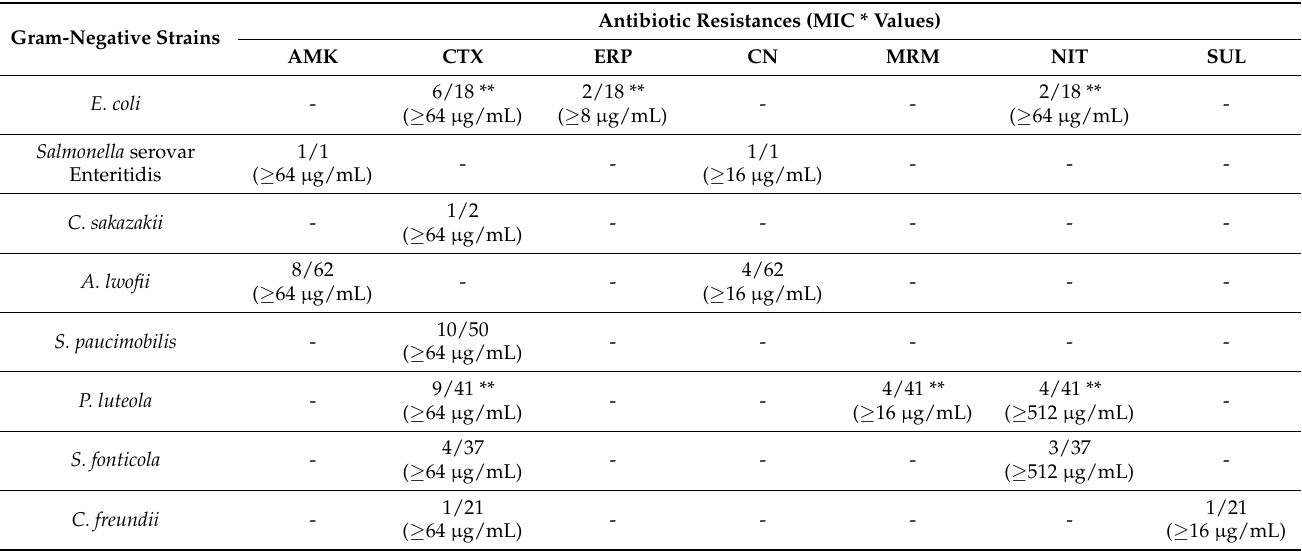
Table 7. Gram-negative bacterial strains: the phenotypic resistance